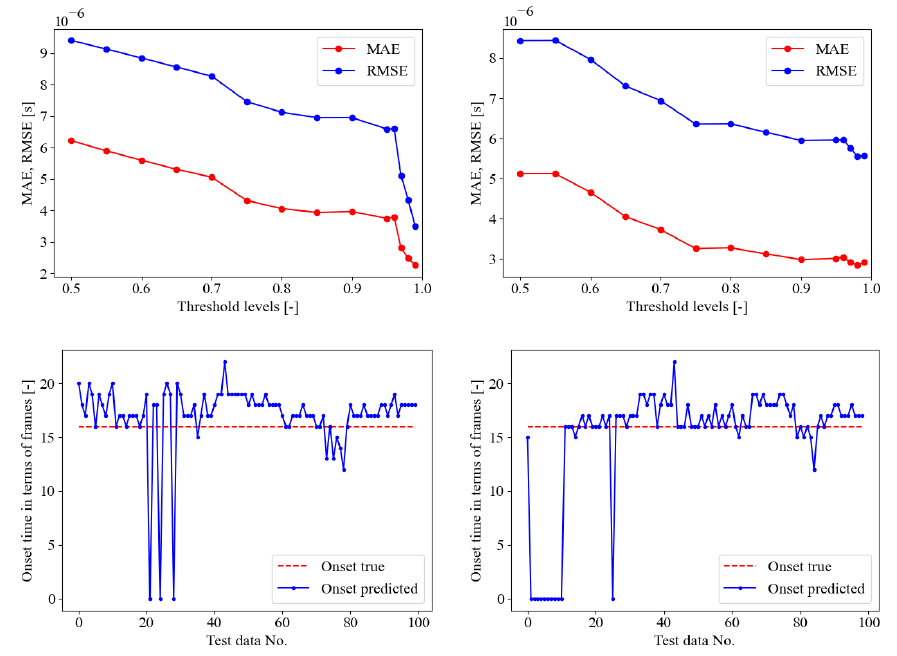
Figure 9. SED trained on AE only (training set: PLB test A). Upper pane, crack class probability threshold evaluation, lower pane onset time predictions in terms of frames on the PLB test sets B and C for optimal threshold. From left to right, PLB test B (optimal threshold of 99%), and C (optimal threshold of 98%). The onset time true values are always at a constant pre-trigger time of 256 µ s (frame No.